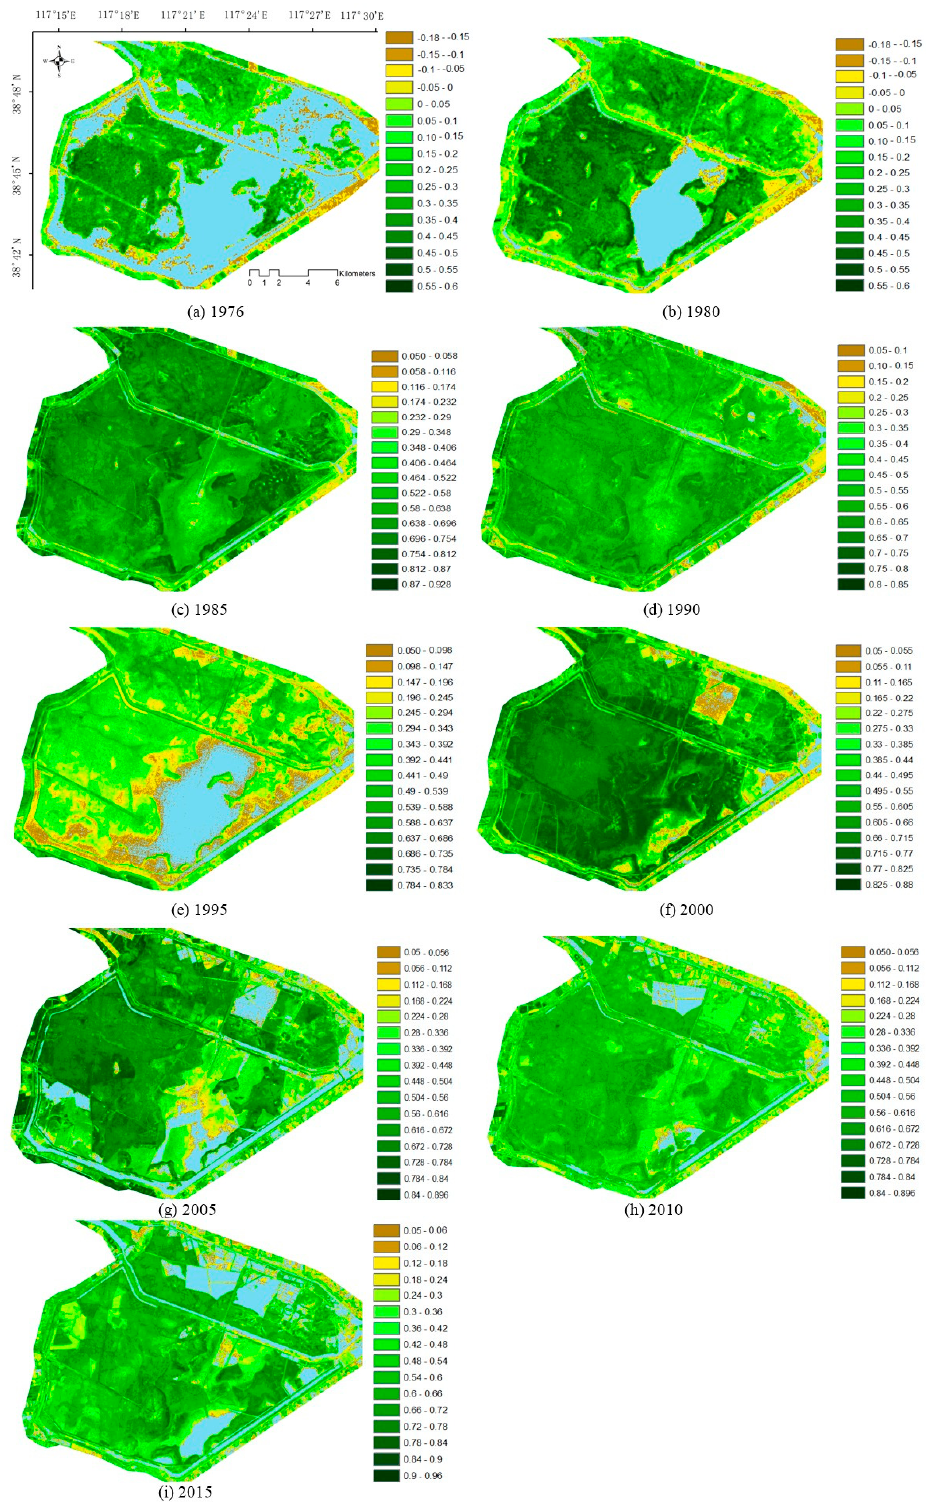
Figure 10. The NDVI of the long-term series of Landsat satellite datasets from 1976 to 2015. ( a – i ) correspond to 1976, 1980, 1985, 1990, 1995, 2000, 2005, 2010, and 2015 NDVI results.